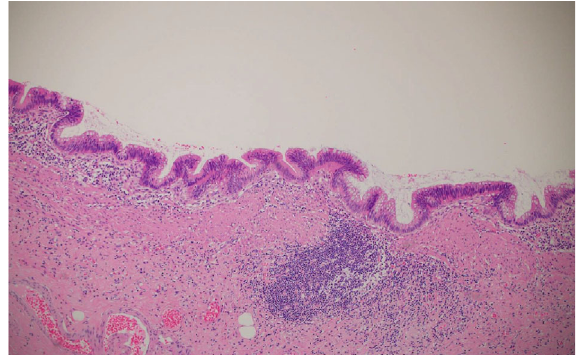
Figure 6: High power displaying the atypical mucosa, H and E × 20.